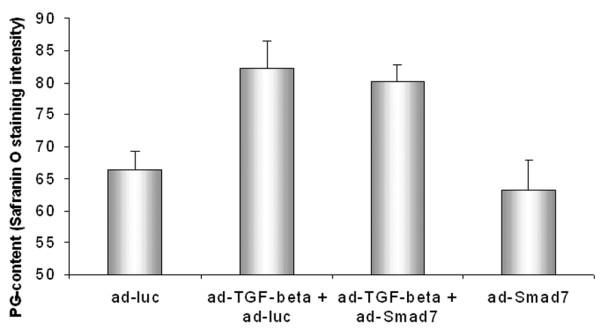
Proteoglycan (PG) content of osteoarthritits (OA) cartilage in STR/ort mice. STR/ort mice (4 weeks old) were injected intra-articularly with Ad-transforming growth factor-β (TGF-β) combined with Ad-Smad7 or Ad-luciferase and injected again 2 weeks later. Four weeks after the first injection, knee joints were isolated and the effect of TGF-β overexpression on PG content was assessed. TGF-β exposure resulted in a significantly higher PG content of cartilage than luciferase-injected controls (p < 0.05). Co-expression with Smad7 had no effect on the PG content. Error bars display standard error.